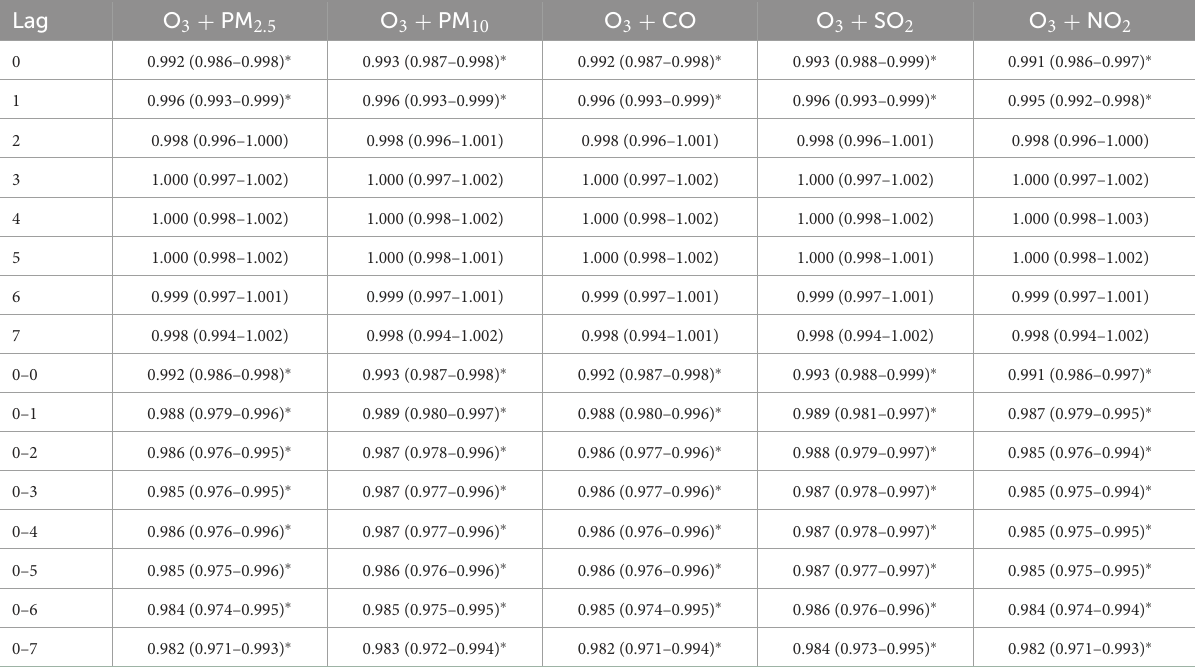
TABLE 4 The association between an increase of 10 µ g/m 3 of O 3 and CHD admission in Hefei, 2014–2021 (dual pollutant model). Lag O 3 + PM